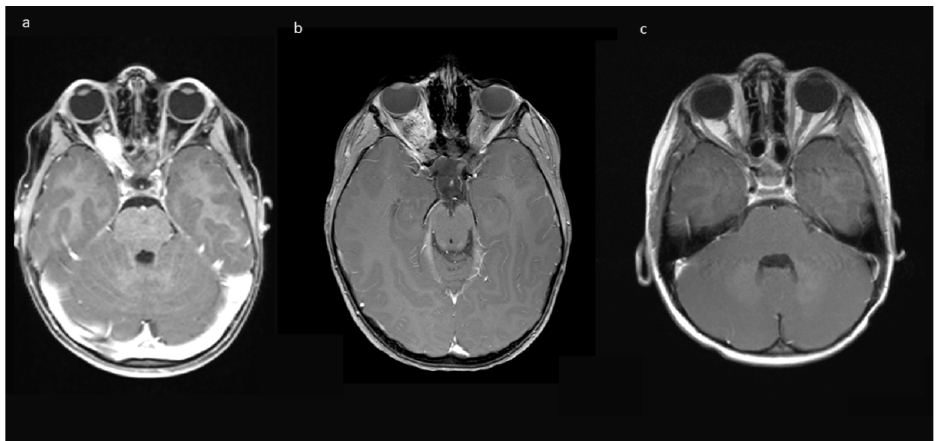
Figure 1. Exemplary MR-imaging of a 3-year-old male ( a ) preoperatively, ( b ) 1 month postoperatively, and ( c ) 2 years postoperatively.